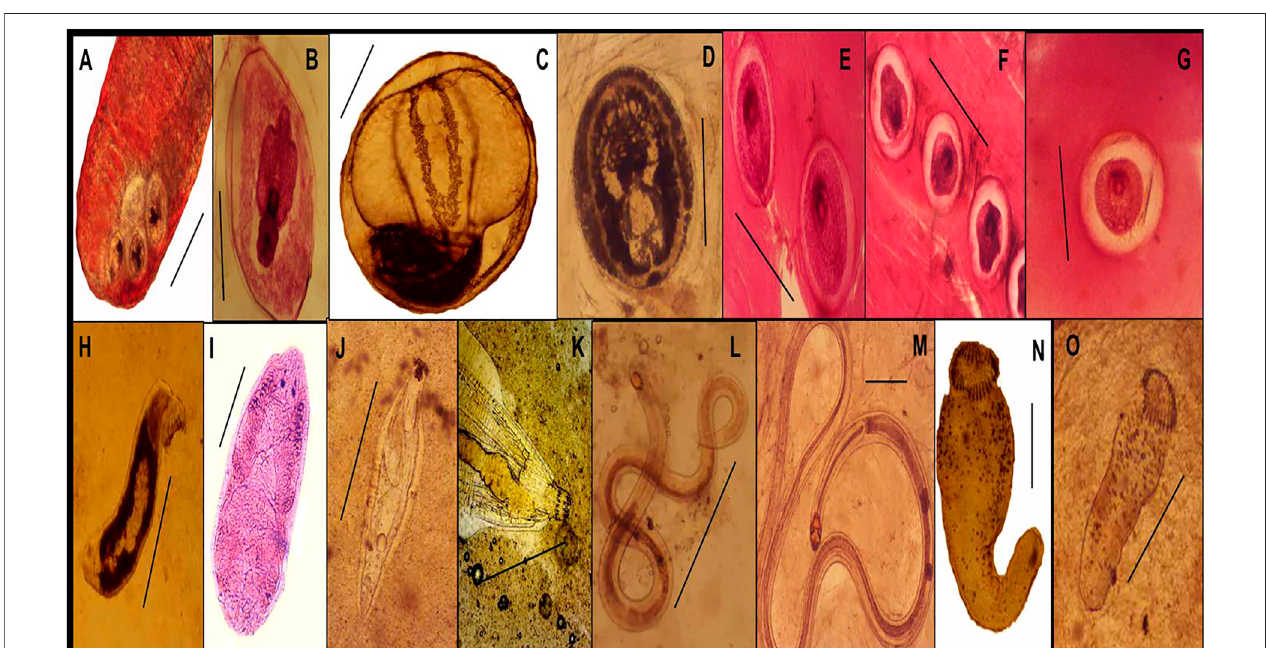
FIGURE 3 | Encysted metacercariae (EMC) of identi fi ed infected fi shes (Scale bar = 50 µm). (A) : Centrocestus formosanus . (B) : Diplostomum tilapiae stained with acetic acid alum carmine. (C) : Opisthorchis sp . (D) : Cyanodiplostomum sp . (E) : Prohemistomum sp. stained with acetic acid alum carmine (F) : Pygidiopsis genata stainedwithaceticacidalumcarmine (G) : Heterphyes sp.stainedwithaceticacidalumcarmine (H – O) .Helminthparasitesidenti fi edininfected fi sh(Scalebar=0.5 mm). (H) : Cichlidogyrus tilapiae . (I) : Enterogyrus cichlidarum, stained with acetic acid alum carmine (J) : Acanthosentis tilapiae. (K) : anterior part of A. tilapiae. (L) : Procamallanus sp. (M) : Paracamallanus sp. (N,O) : Procercoid and pleurocercoid stage of Polyonchobothrium